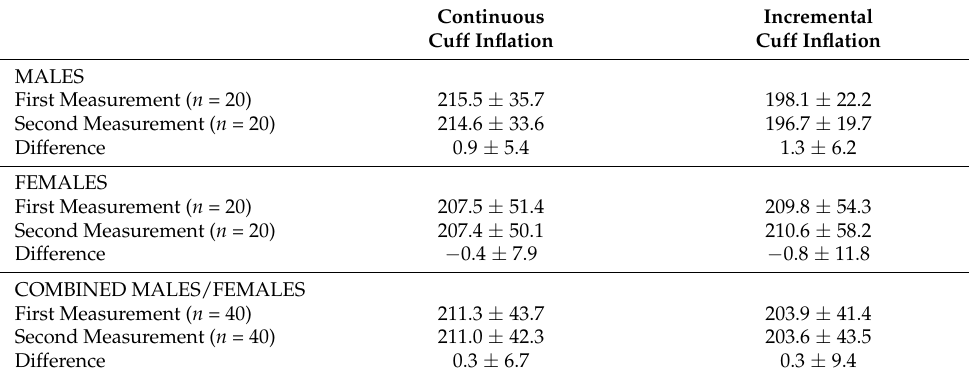
Table 4. Repeated Measures of AOP Using Two Cuff Inflation